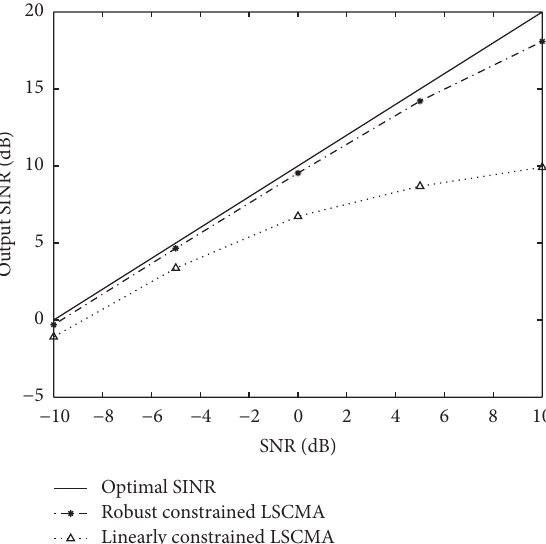
Figure 7: Output SINR versus SNR (in the mismatch